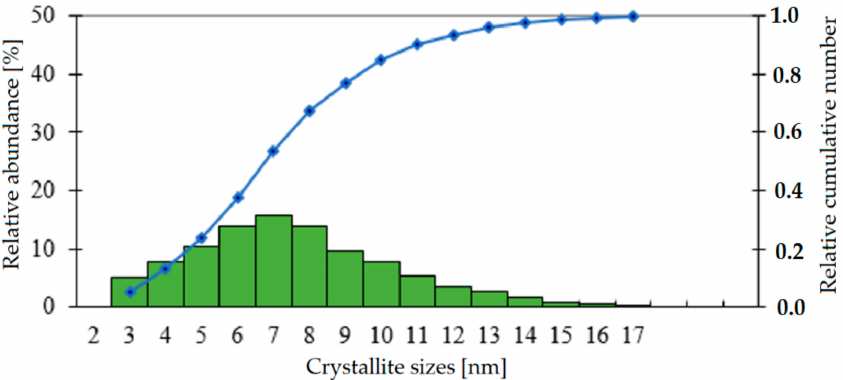
Figure 8. Relative count and cumulative number for the sizes of crystallites of silver, as determined based on TEM